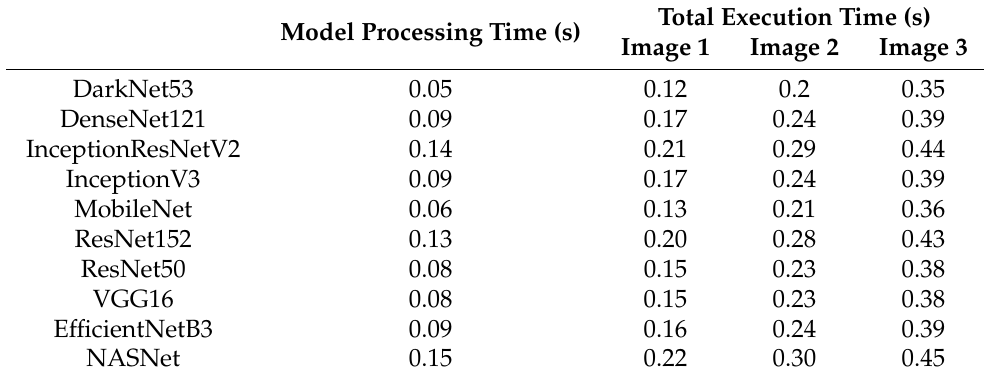
Figure 12. Conceptual block diagram of framework for partial automation of visual blockage classification. Table 2. CNN model processing times for three different size